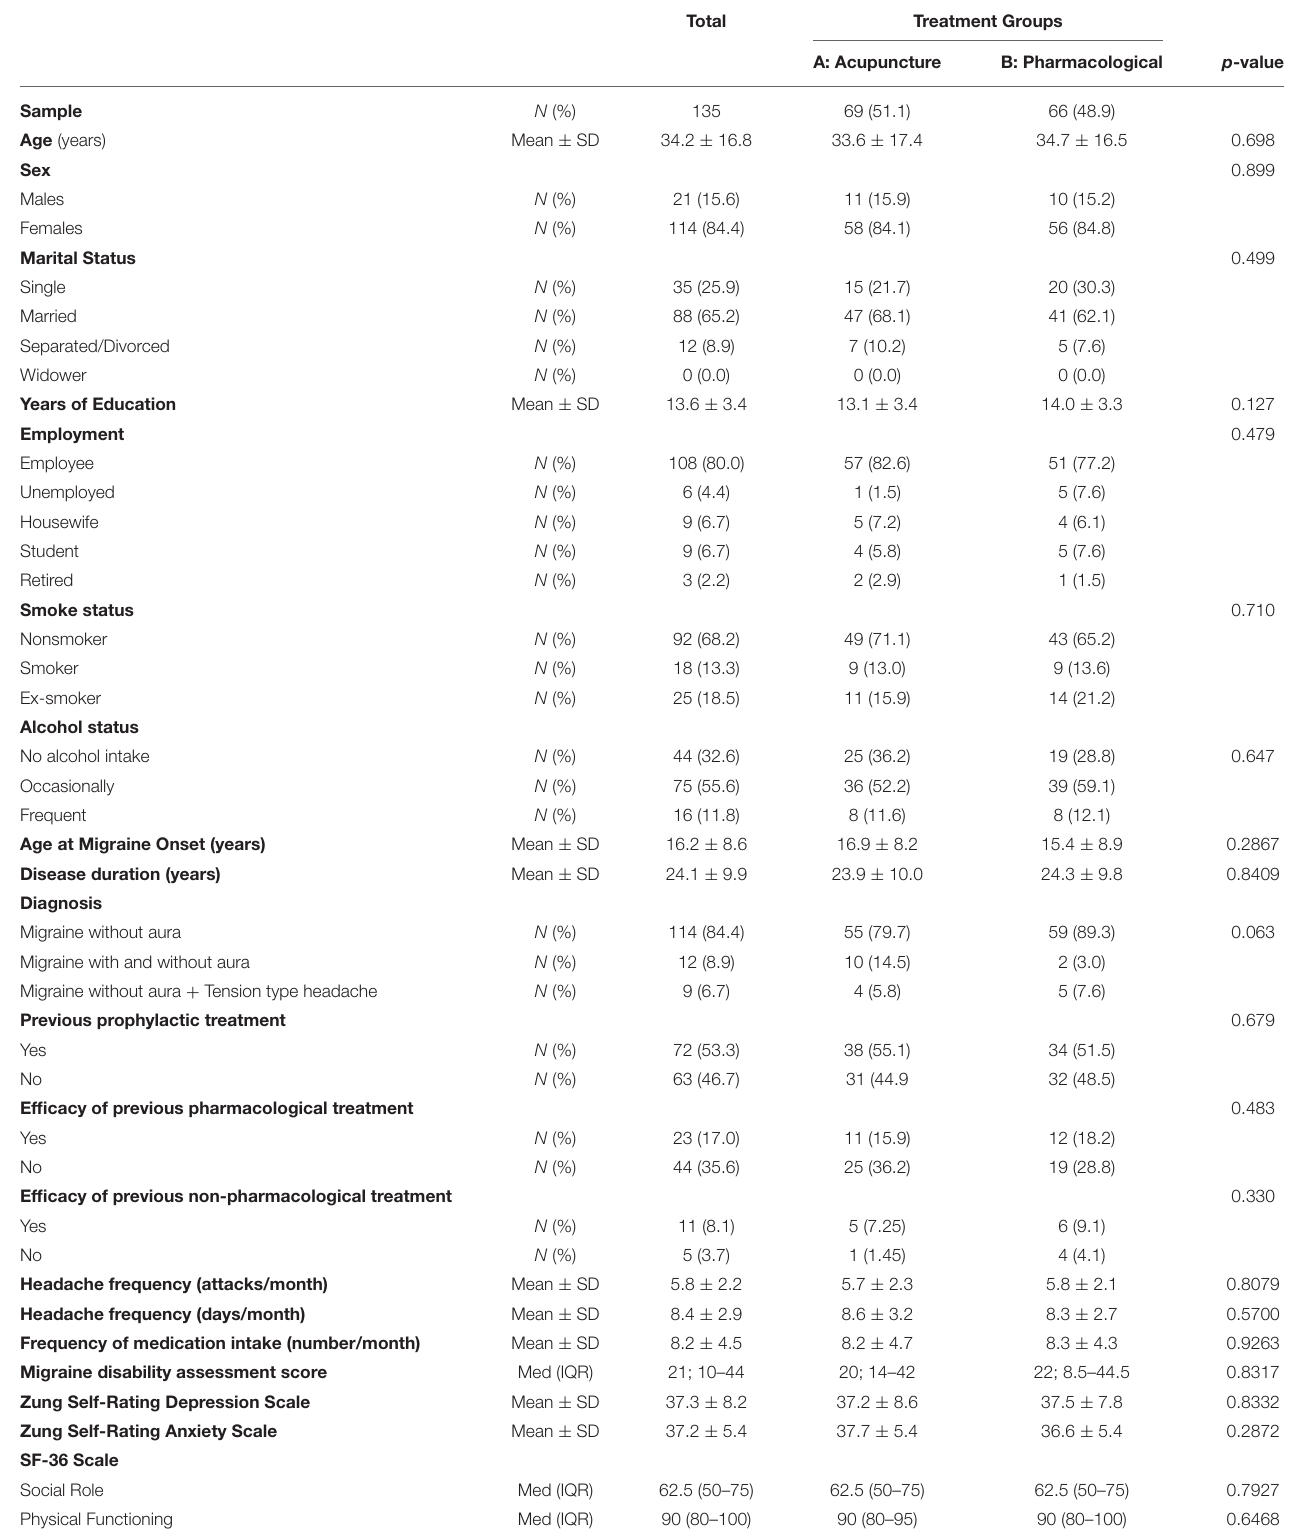
TABLE 1 | Demographic and baseline clinical characteristics of the study